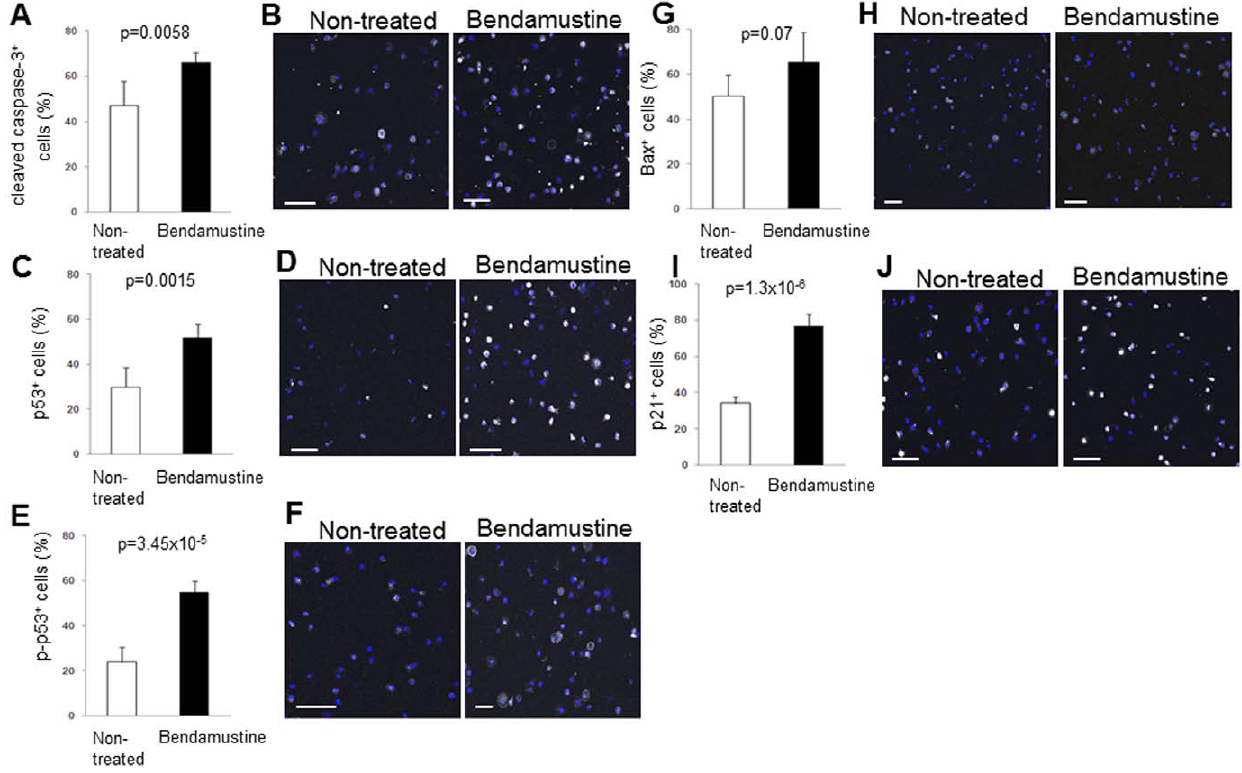
Figure 8. Bendamustine induces p53-dependent apoptosis. Human CD138 + mouse CD45 2 MM cells from non-treated or bendamustine- treated mice were sorted and immunocytochemistry was performed to analyze cleaved caspase-3 ( A, B ), p53 ( C, D ), phosphorylated-p53 ( E, F ), Bax ( G, H ), and p21 ( I, J ). Each group of MM cells was stained with DAPI and anti-fibronectin antibody, anti-p53 antibody, anti-phosphorylated-p53 antibody, anti-Bax antibody, or anti-p21 antibody. At least 100 cells/sample were counted (mean 6 SD, n=10). Bars=50 m m.